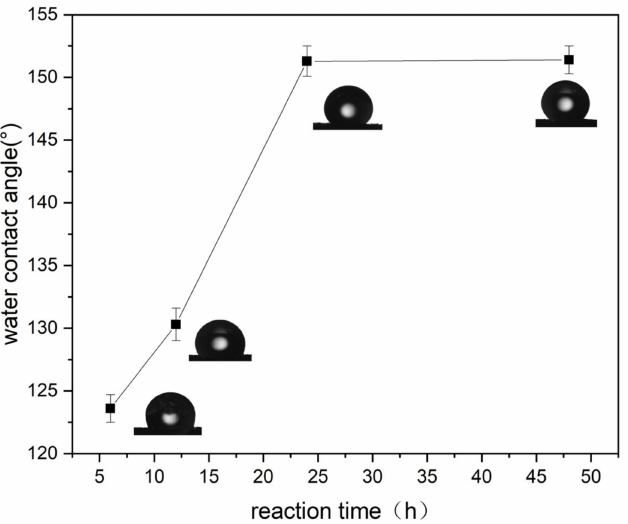
Figure 5. Effect of coupling time on the WCA (experimental conditions: pH = 7, coupling time = 24 h at 25 ◦